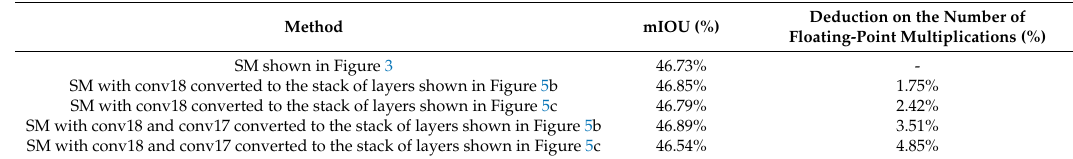
Table 4. The influence of exchanging width for depth on the SM. Performance is evaluated with mIOU.